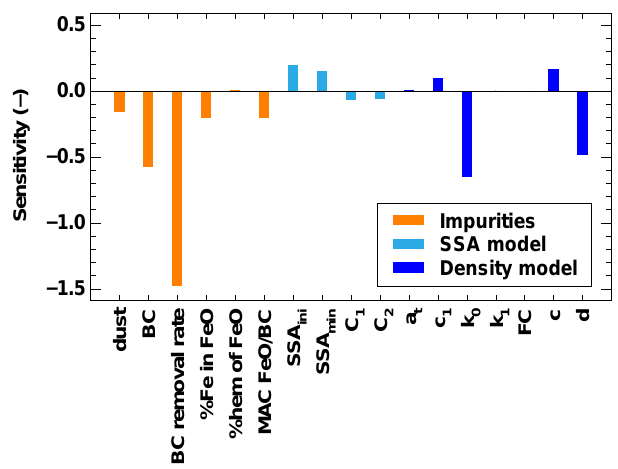
Figure 9. Sensitivity of annual surface mass balance (i.e., the per- centage change in the parameter value vs. the percentage change in annual mass balance) to the different parameters of the impurity, the specific surface area and the snow density model, as well as the sensitivity to the input of mineral dust and